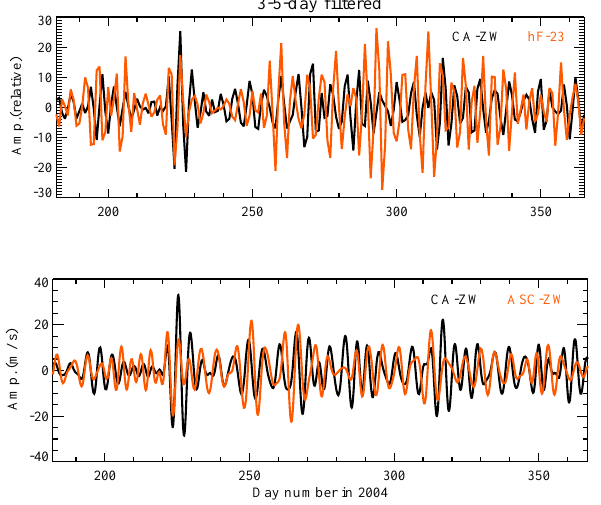
Fig. 7. Amplitude of the oscillation of the 5–7-day filtered h 0 F at Fortaleza (red line) and zonal wind at Cariri (black line) (top), and zonal wind at Ascension Island. (red) and Cariri (black) (bottom). There is no wind data for Ascension from day 275 to day